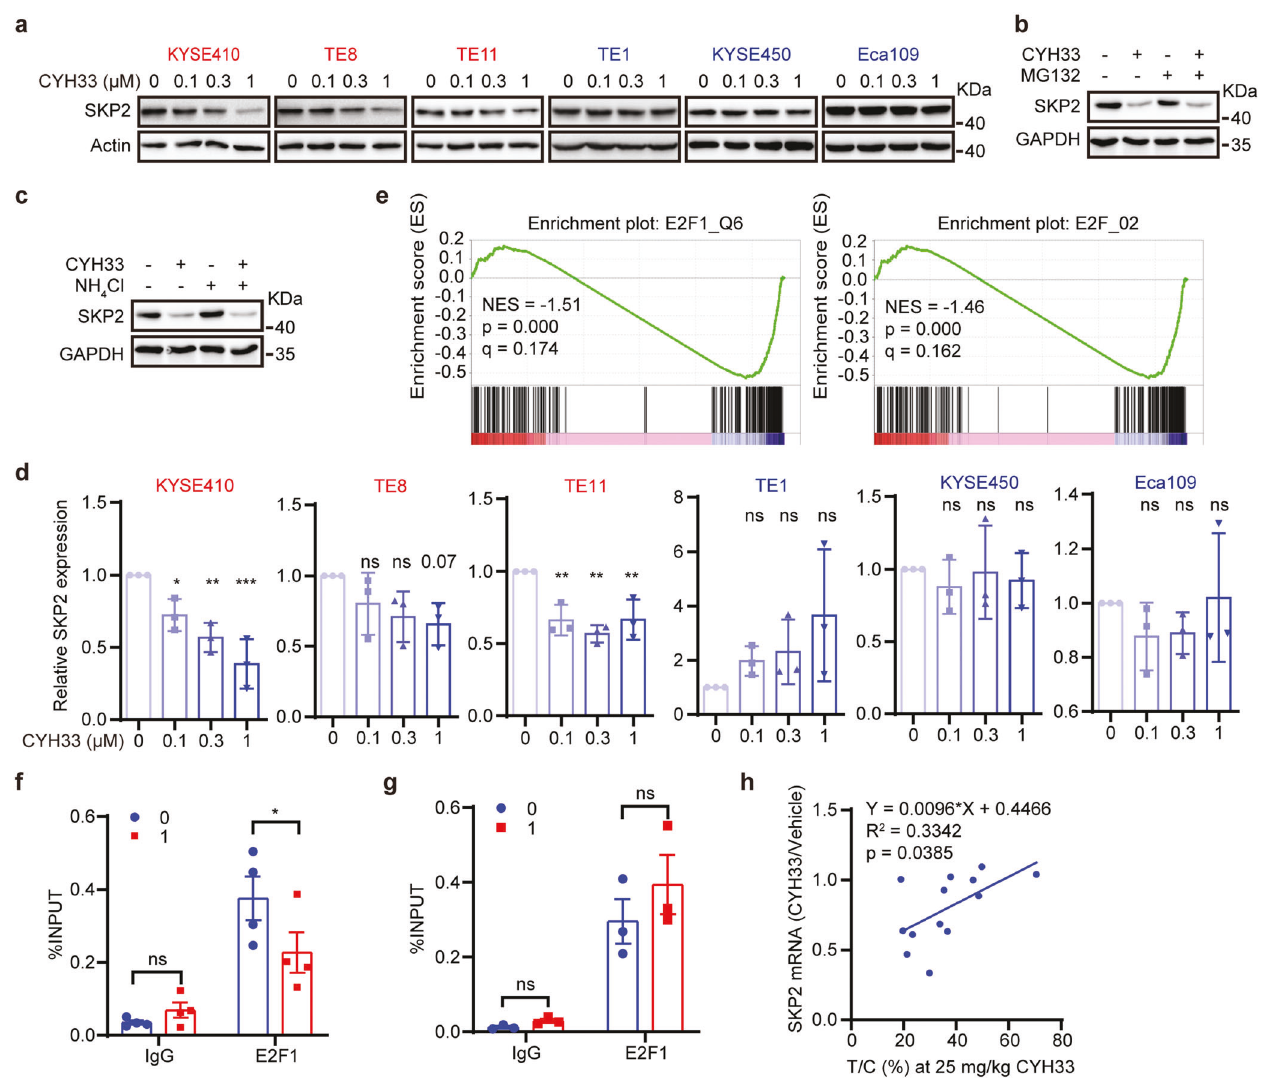
Fig. 5 CYH33 down-regulated the expression of SKP2 via attenuating E2F1-mediated transcription. a ESCC cells were treated with CYH33 at indicated concentrations for 24 h and cell lysates were subjected to Western blot with the indicated antibodies. b , c KYSE410 cells were treated with CYH33 and MG132 ( b ) or NH 4 Cl ( c ) and cell lysates were subjected to Western blot with the indicated antibodies. d ESCC cells were treated with CYH33 at indicated concentrations for 24 h and the mRNA level of SKP2 was measured by quantitative real time PCR ( n = 3). e Gene set enrichment analysis was performed in KYSE410 cells treated with CYH33 (1 μ M) for 24 h focusing on “ C3 transcription factor targets ” . Down-regulation of “ E2F1_Q6 ” and “ E2F_02 ” gene sets were presented. f , g ChIP assays were performed with the antibody against E2F1 in KYSE410 ( f , n = 4) or KYSE450 ( g , n = 3) cells treated with CYH33 (1 μ M) for 24 h. Fold enrichment of E2F1 in the promoter region of SKP2 was presented. h RNA sequencing was performed in ESCC PDX samples treated with CYH33. Pearson correlation analysis of the T/C values and the SKP2 mRNA level in CYH33 treatment group versus that in vehicle group was presented. Data were presented as mean ± SD. p values were analyzed using two-tailed one-way ANOVA with Tukey multiple group comparison test. ns, p > 0.05; * p < 0.05; ** p < 0.01; *** p <